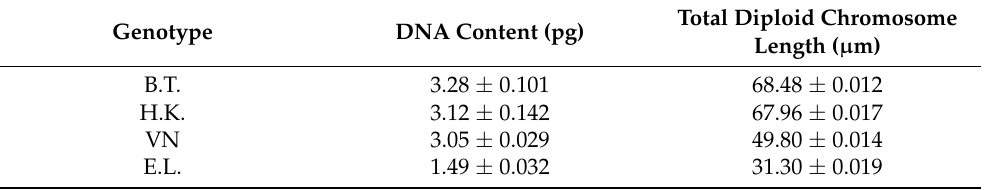
Table 3. Nuclear DNA content and total diploid chromosome length in studied genotypes of P. vulgaris L.